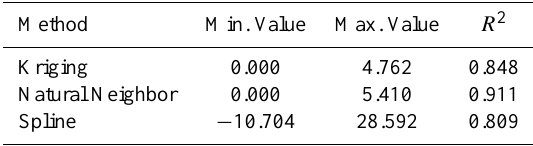
Table 1. Comparison of interpolation